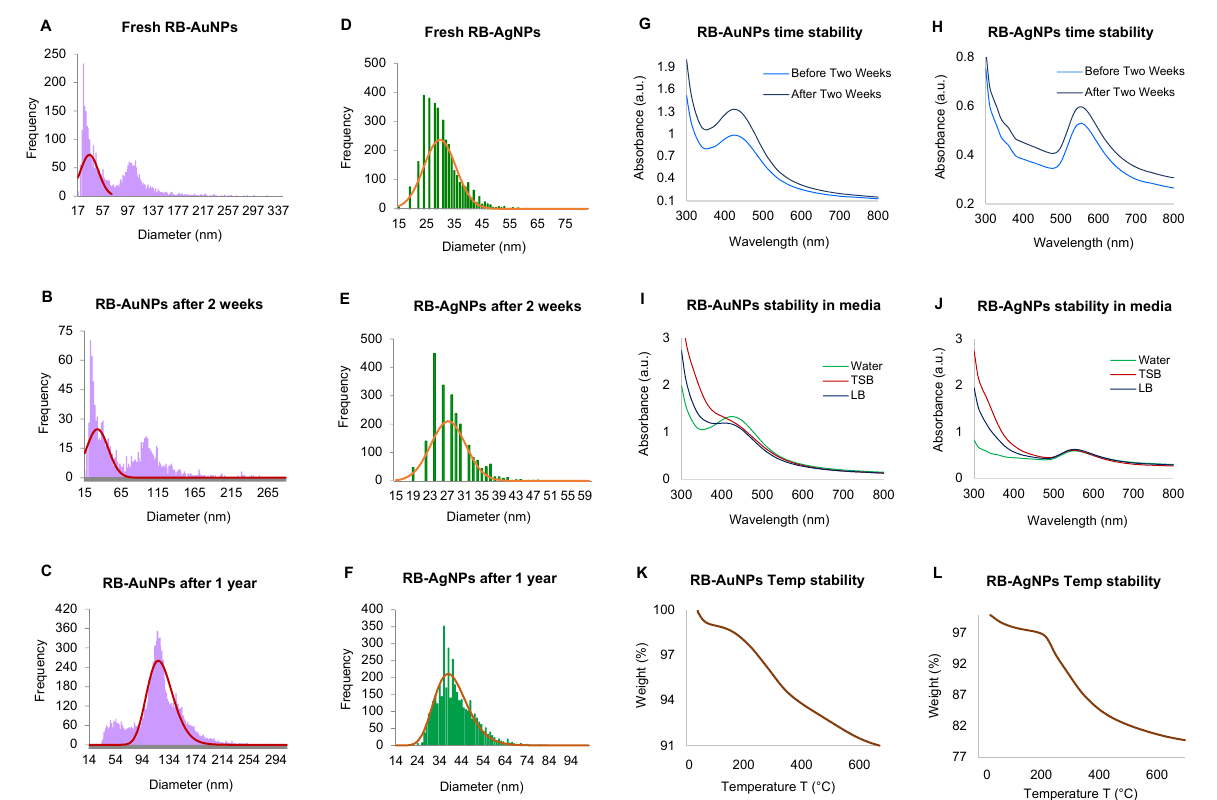
Figure 5. sp-ICPMS and stability analysis of RB-AuNPs and RB-AgNPs. ICPMS histogram of RB- AuNPs at different time intervals ( A ) fresh RB-AuNPs, ( B ) after two weeks, ( C ) after one year at 4 ◦ C. ICPMS histogram of RB-AgNPs at different time intervals, ( D ) fresh RB-AuNPs, ( E ) after two weeks, ( F ) after one year at 4 ◦ C. UV-Vis spectrum representing the stability analysis, before and after two weeks of incubation at RT for ( G ) RB-AuNPs and ( H ) RB-AgNPs; in a different medium ( I ) RB-AuNPs, ( J ) RB-AgNPs; at the temperature range from 20–700 ◦ C measured by TGA instrument ( K ) RB-AuNPs, ( L )